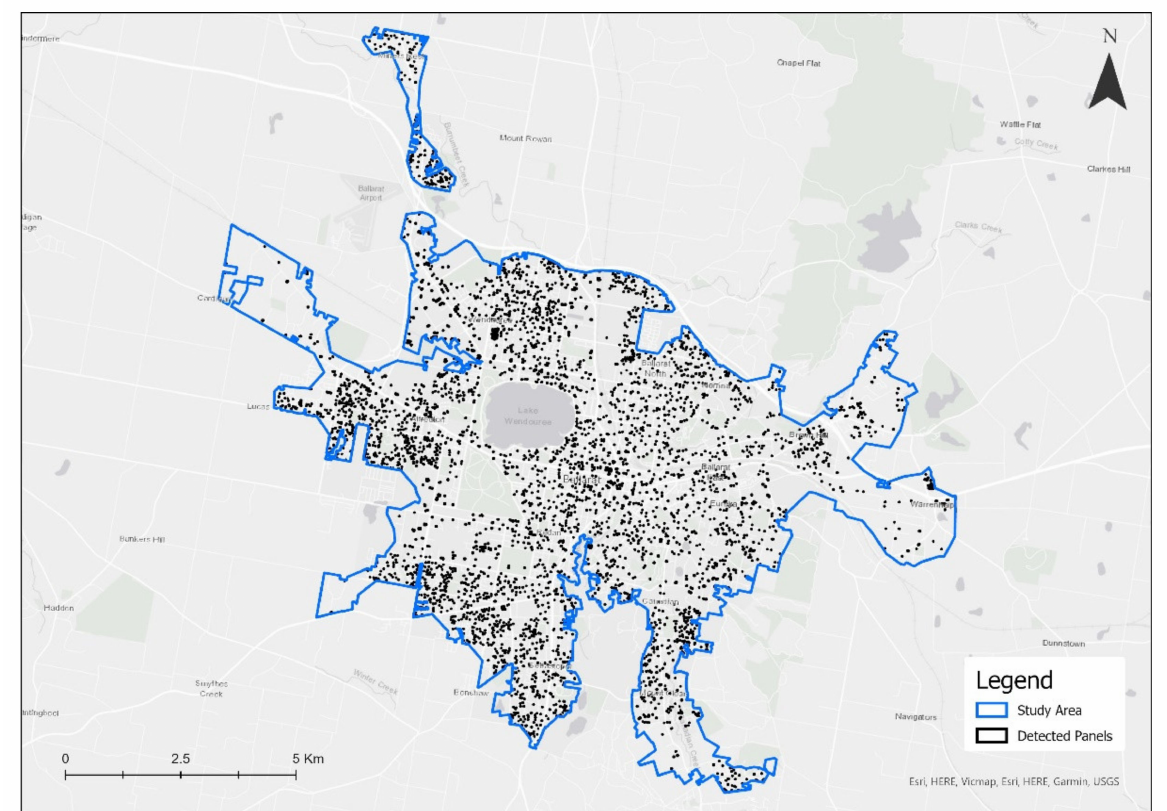
Figure 6. Spatial distribution of the detected solar panels. Depicting the existing solar panels does not provide a full understanding of the